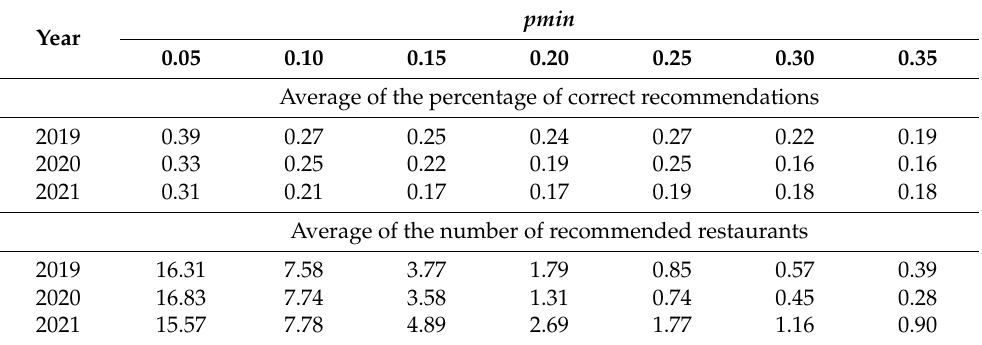
Figure 7. Percentage of correct recommendations ( y -axis) in a scale from 0 to 1, according to the values of the parameters ( x -axis). Vertical lines represent the standard deviation. ( a ) Testing different values for pmin , k = 5. ( b ) Testing different values for k , pmin = 0.1. Table 4. Results of our proposed recommendation system according to the value of the parame- ter pmin